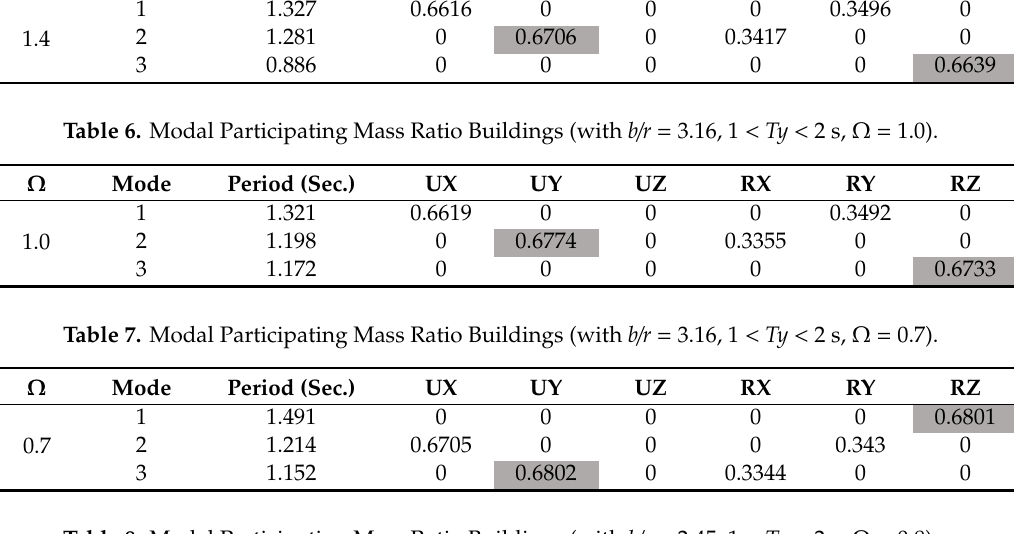
Table 8. Modal Participating Mass Ratio Buildings (with b / r = 2.45, 1 < Ty < 2 s, Ω = 0.8).